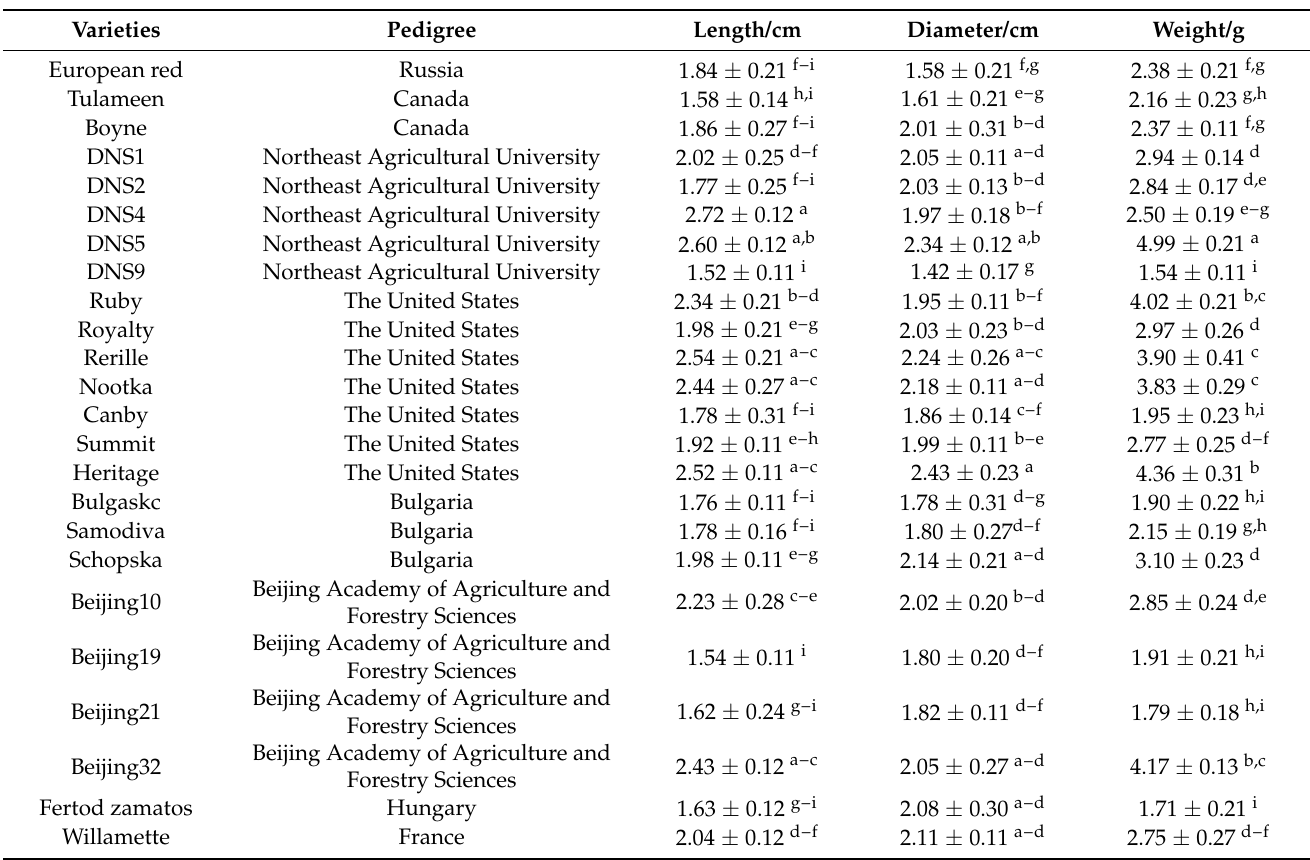
Table 1. The physical properties of 24 red raspberry